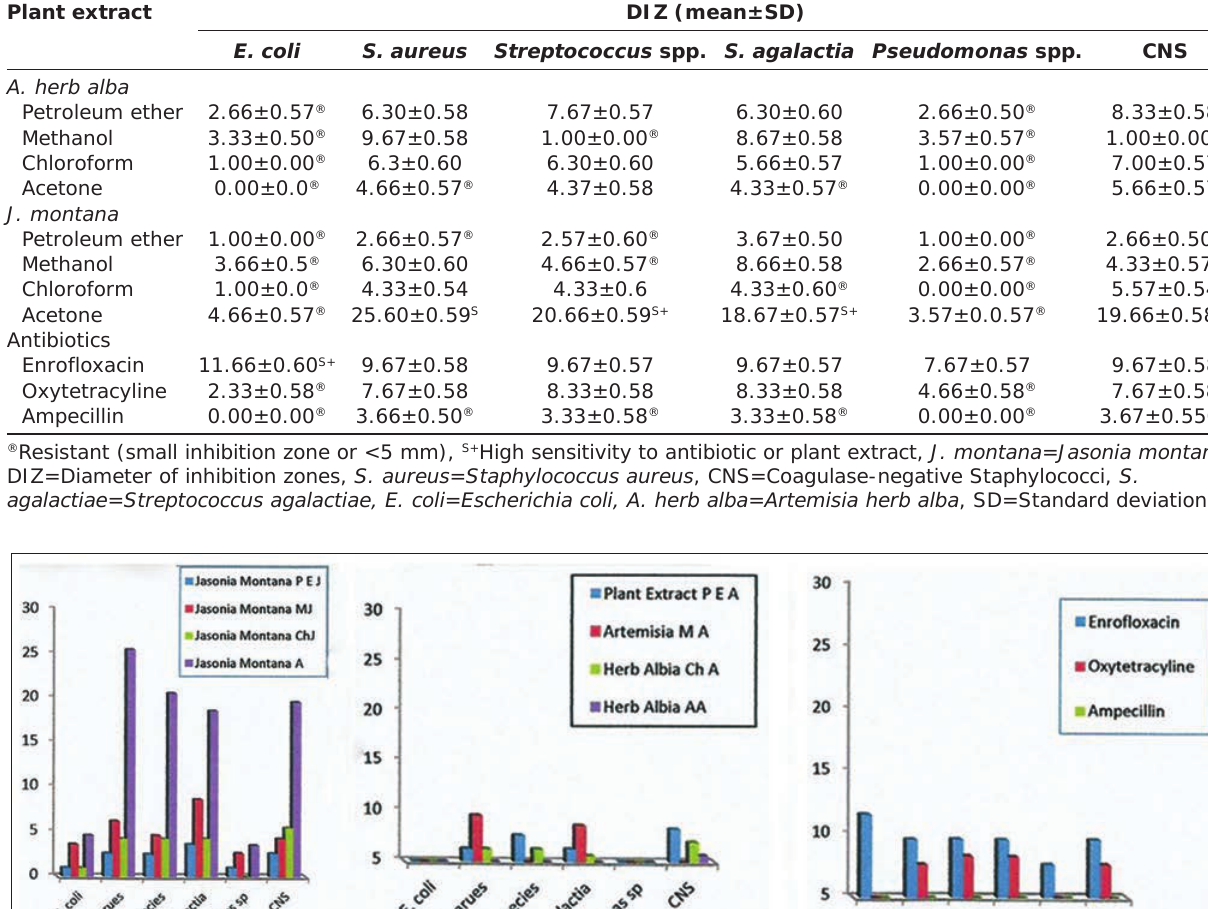
Table-3: Antimicrobial activity of A. herb alba and J. montana extracted by different chemical solvents on bacteria isolated from bovine mastitis by disk diffusion method (values were calculated as means of triplicates). Plant extract